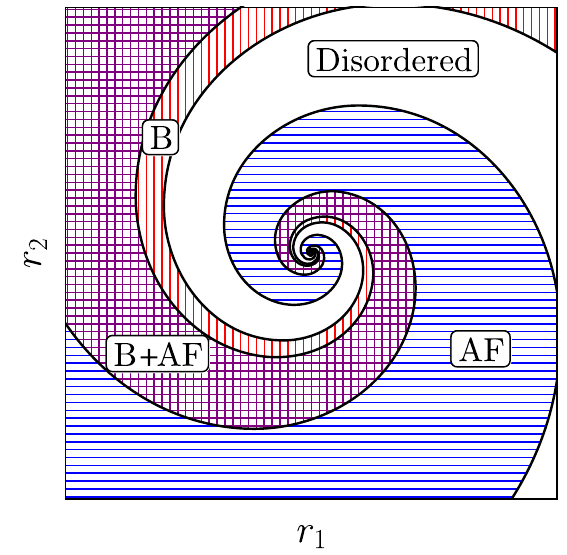
FIG. 4. Phase diagram associated with the NEFPs of the nonequilibrium Ising model of two coupled fields for h ¼ 0 . The white region indicates the disordered phase, B (red vertical shading) corresponds to the phase where the bistability order parameter undergoes spontaneous symmetry breaking, AF (blue horizontal shading) denotes antiferromagnetic ordering, and B þ AF (purple square shading) corresponds to the phase where both order parameters are nonzero. The solid black lines denote second-order phase transitions. The NEFP phase diagram ex- hibits logarithmic spirals in the phase boundaries. The other NEFP is described by an analogous diagram upon switching the roles of the two order parameters (B ↔ AF, r 1 ↔ r 2